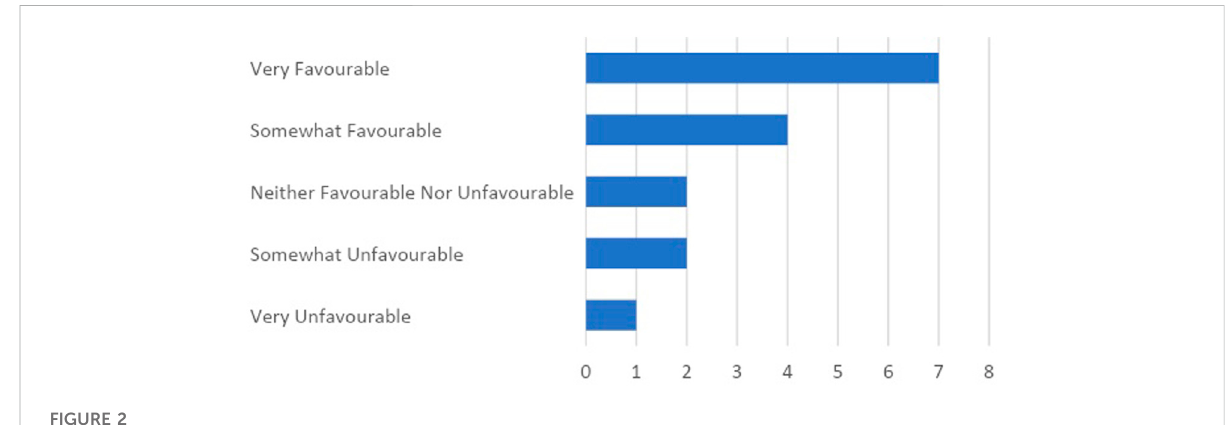
FIGURE 2 Teachers ’ initial assessment of TPRs.